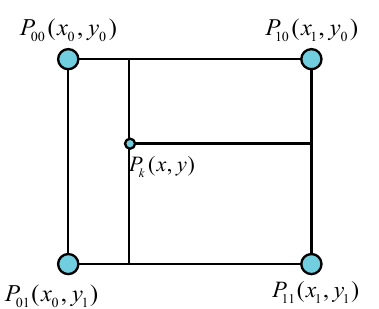
Figure 5. The reference magnetic field strength value from bilinear interpolation at P